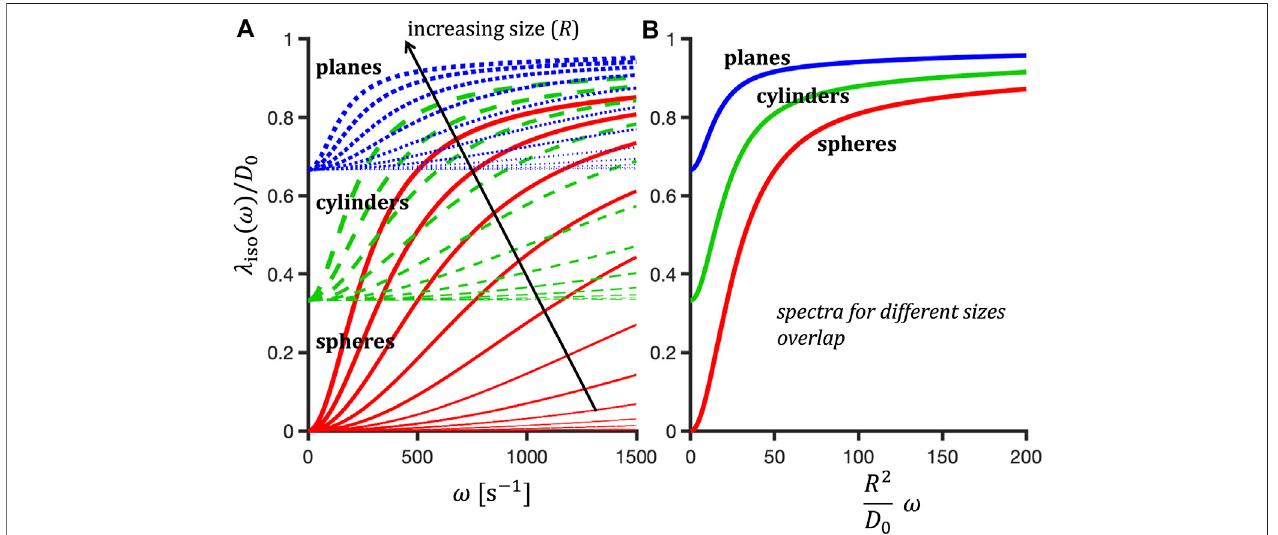
FIGURE 1| Normalized isotropic diffusion spectra, λ iso ( ω )/ D 0 , for randomly oriented restrictions ofvaried shapes and sizes shown as a function of frequency (A) or ω (B) . On the Ω -scale, the restricted diffusion spectra are independent of size for any given geometry. In the limit of zero frequency, the the normalized frequency Ω ≡ R 2 D 0 isotropic diffusion spectra are determined by 0, 1, and 2 free diffusion components that exist in spherical, cylindrical and planar geometries,